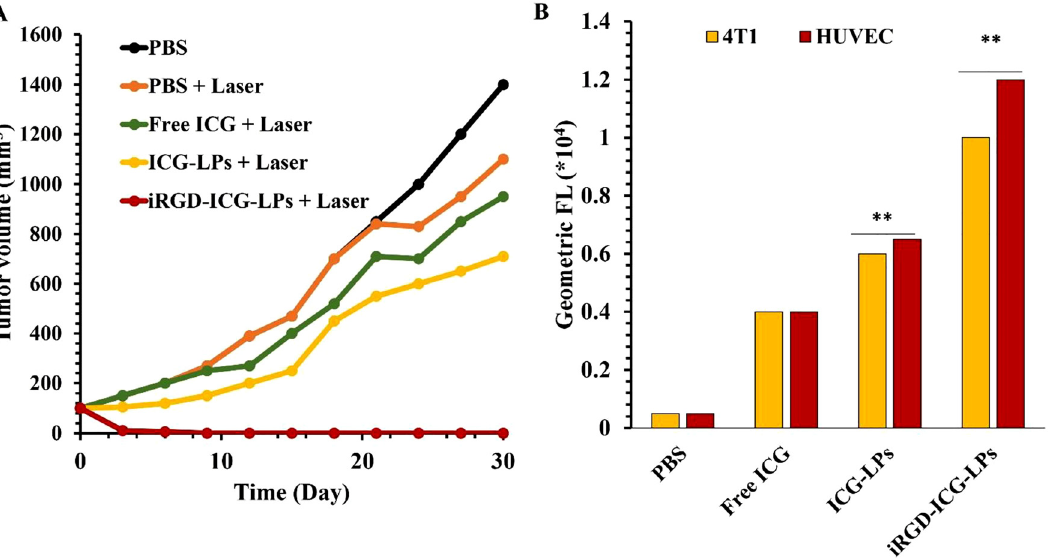
Figure 17: In vivo antitumor effect and safety evaluation. (A)GeometricmeanfluorescenceintensityofHUVECsand4T1cellsfromflowcytometricanalysis,( n =3),(**) P <0.01.(B)Tumorgrowthcurves ofnontreatedmiceormicereceivingiRGD-ICG-LPs,ICG-LPs,freeICG,PBSandlaserirradiationwithin30days.(**) P <0.01.An808nmlaserat a power density of 1.0 W cm − 2 was used to irradiate these samples for 8 min. Adapted from Yan et al.